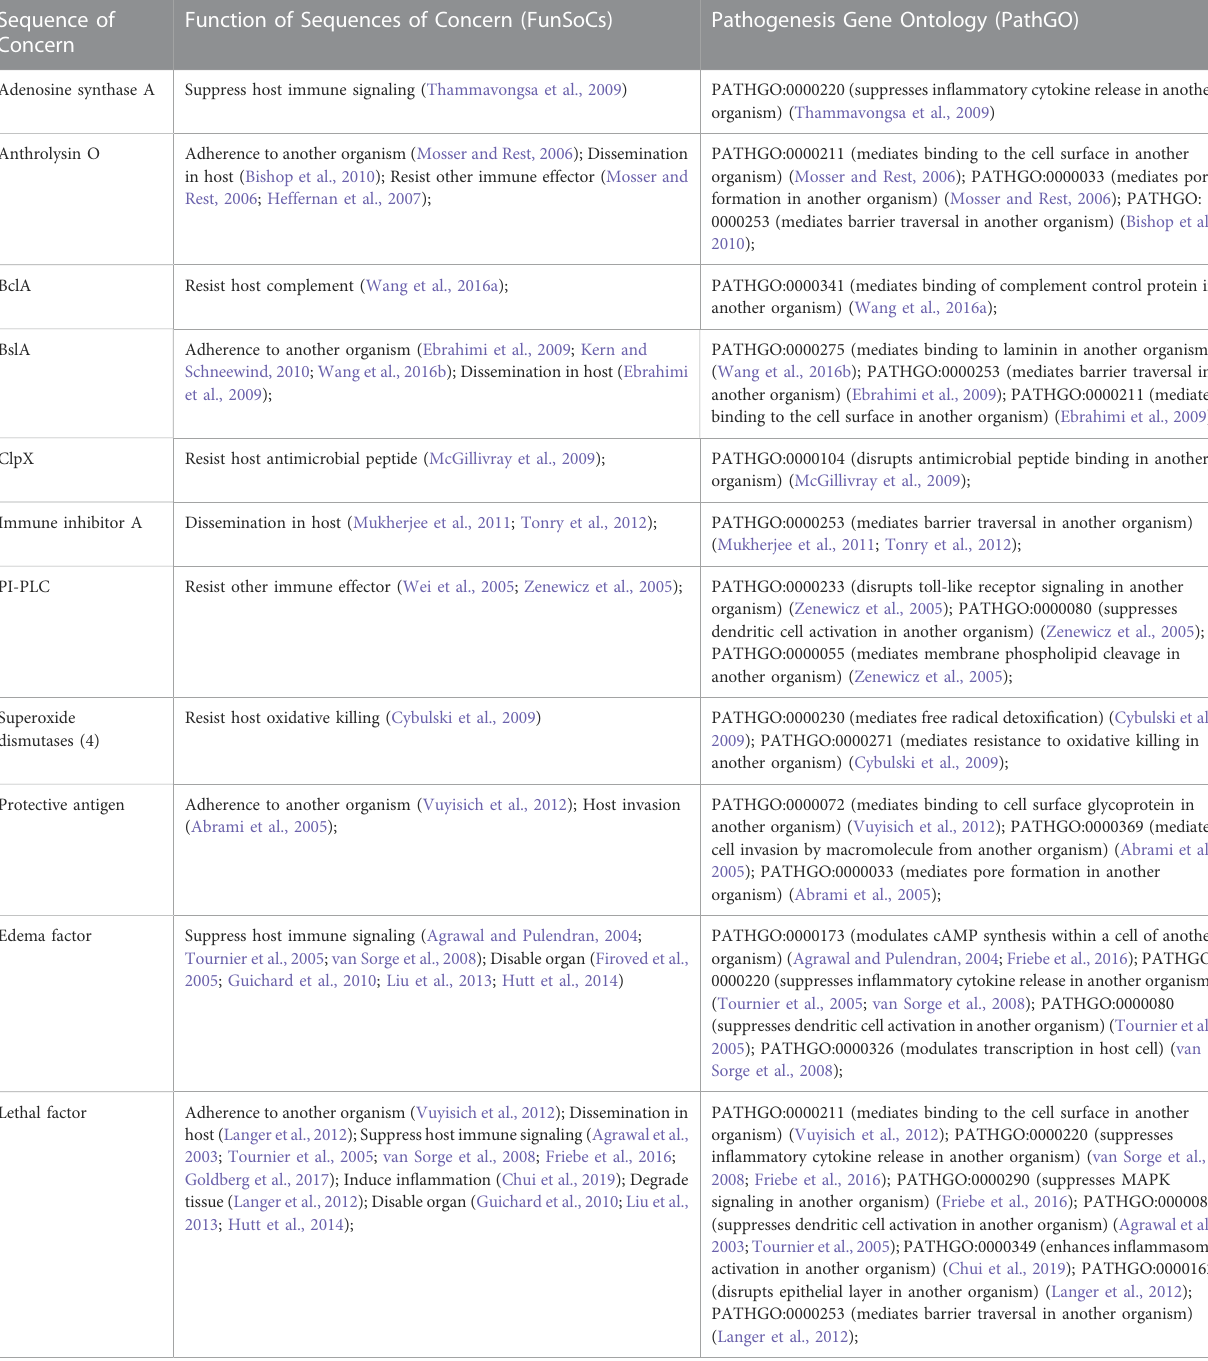
TABLE 4 Sequences of concern of Bacillus anthracis